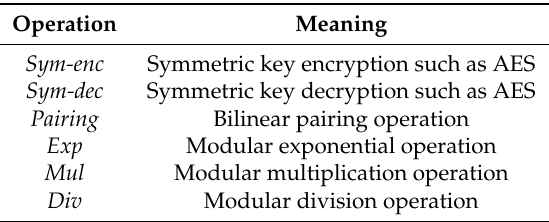
Table 3. Computational complexity notation.